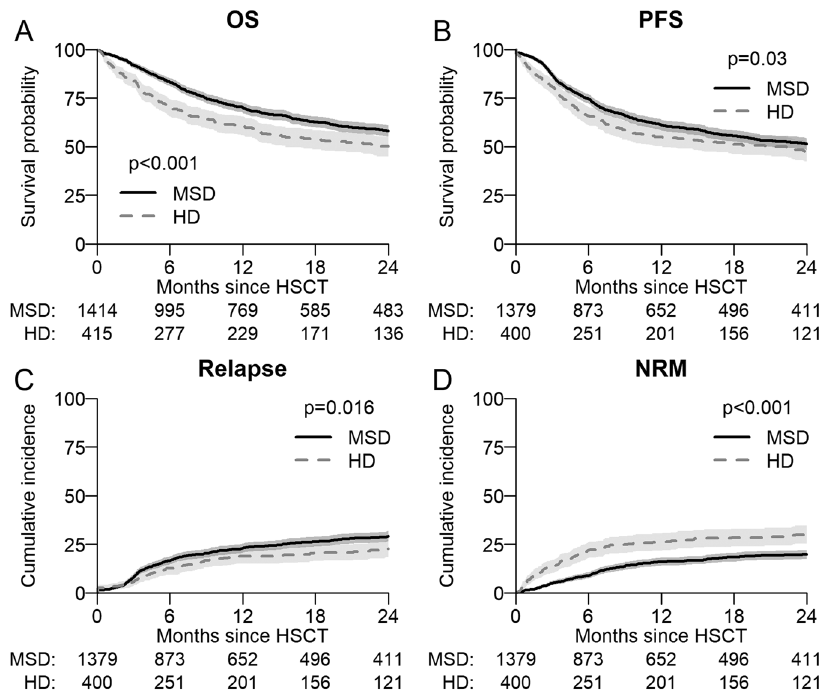
Fig. 1 Survival probability and cumulative incidence of relapse. A Overall Survival (OS) and B Progression Free Survival (PFS) post-transplant of entire cohort as estimated by the method of Kaplan – Meier. C Cumulative Incidences of relapse (CIR) and D Non-Relapse Mortality (NRM) for entire